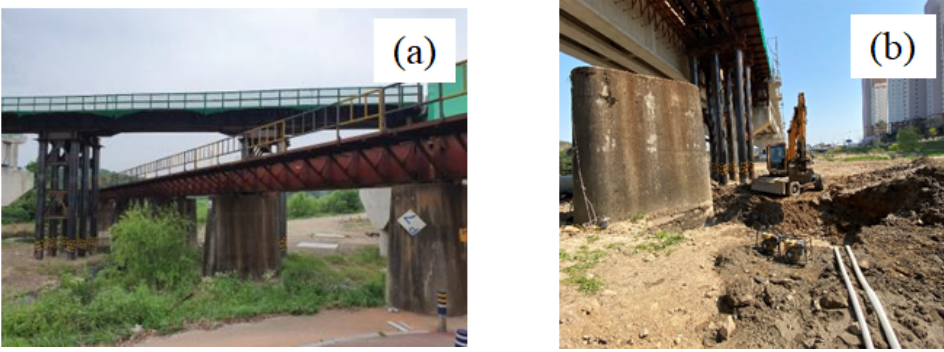
Figure 4. Pier of field experiment ( a ) With girder on the pier and ( b ) without girder on the pier.